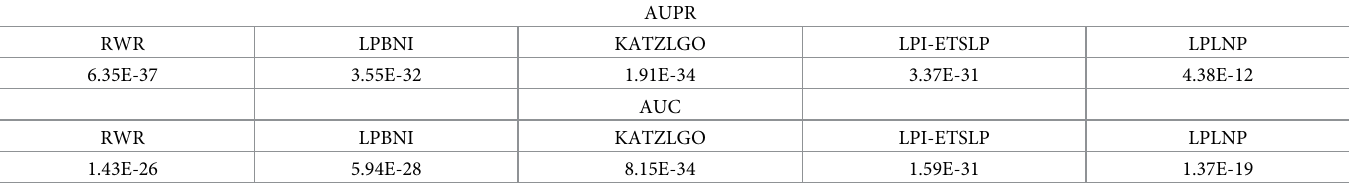
Table 3. Difference between SFPEL-LPI and benchmark methods tested by Paired t-test in terms of AUPR and AUC.